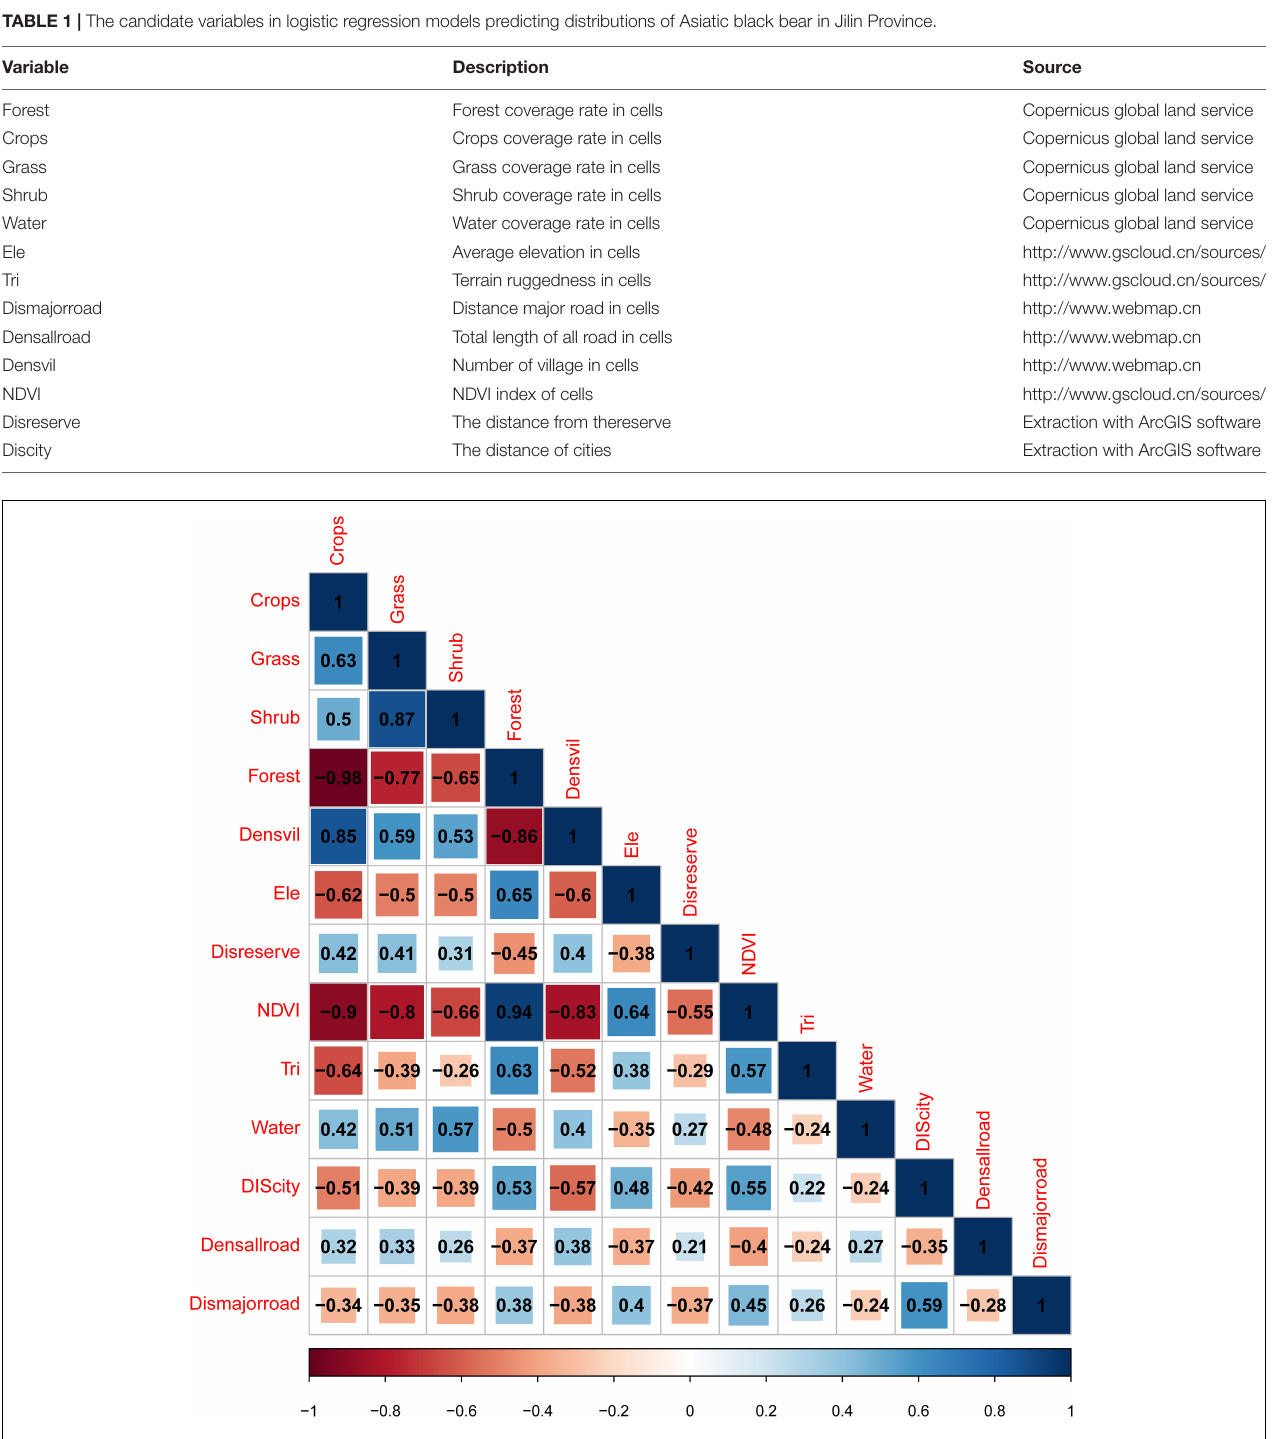
TABLE 1 | The candidate variables in logistic regression models predicting distributions of Asiatic black bear in Jilin